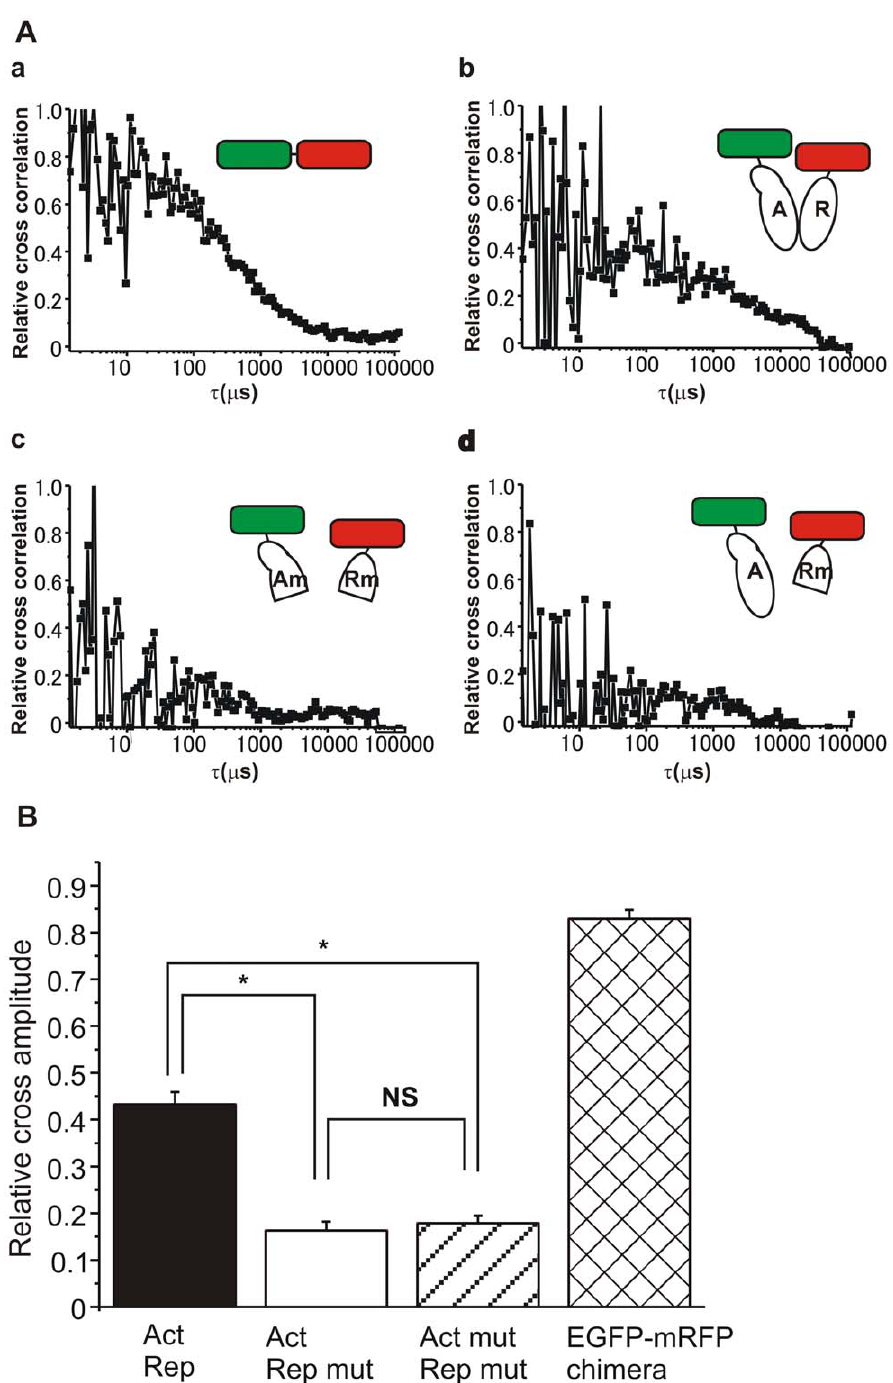
Figure 3. The quantitative evaluation of FCCS data for interaction between CREB1 isoforms. A, Relative cross-correlation [( G c( t ) 2 1)/ ( G r(0) 2 1)] calculated from FCCS measurement. Typical curves of cross-correlation were shown for EGFP- mRFP chimera (a), the EGFP-CREB1 activator isoform protein and the tandem mRFP-CREB1 repressor isoform protein (b), the EGFP-truncated CREB1 activator isoform protein and the tandem mRFP-truncated CREB1 repressor protein (c), and the EGFP-CREB1 activator protein and the tandem mRFP-truncated CREB1 repressor protein (d). B, Relative cross amplitudes [( G c(0) 2 1)/( G r(0) 2 1)] calculated from each FCCS measurement that corresponds to the fraction of the associated molecules ( N c / N g ). Here N c is the average number of particles that have both green and red fluorescence in the excitation-detection volume, and N g is that of the green fluorescent particles. Each relative cross amplitude: EGFP-Act and mRFP-Rep (black bar), EGFP-Act mut and mRFP-Rep mut (white bar), EGFP-Act and mRFP-Rep mut (hatched bar), EGFP-mRFP chimera proteins (cross-hatched bar).